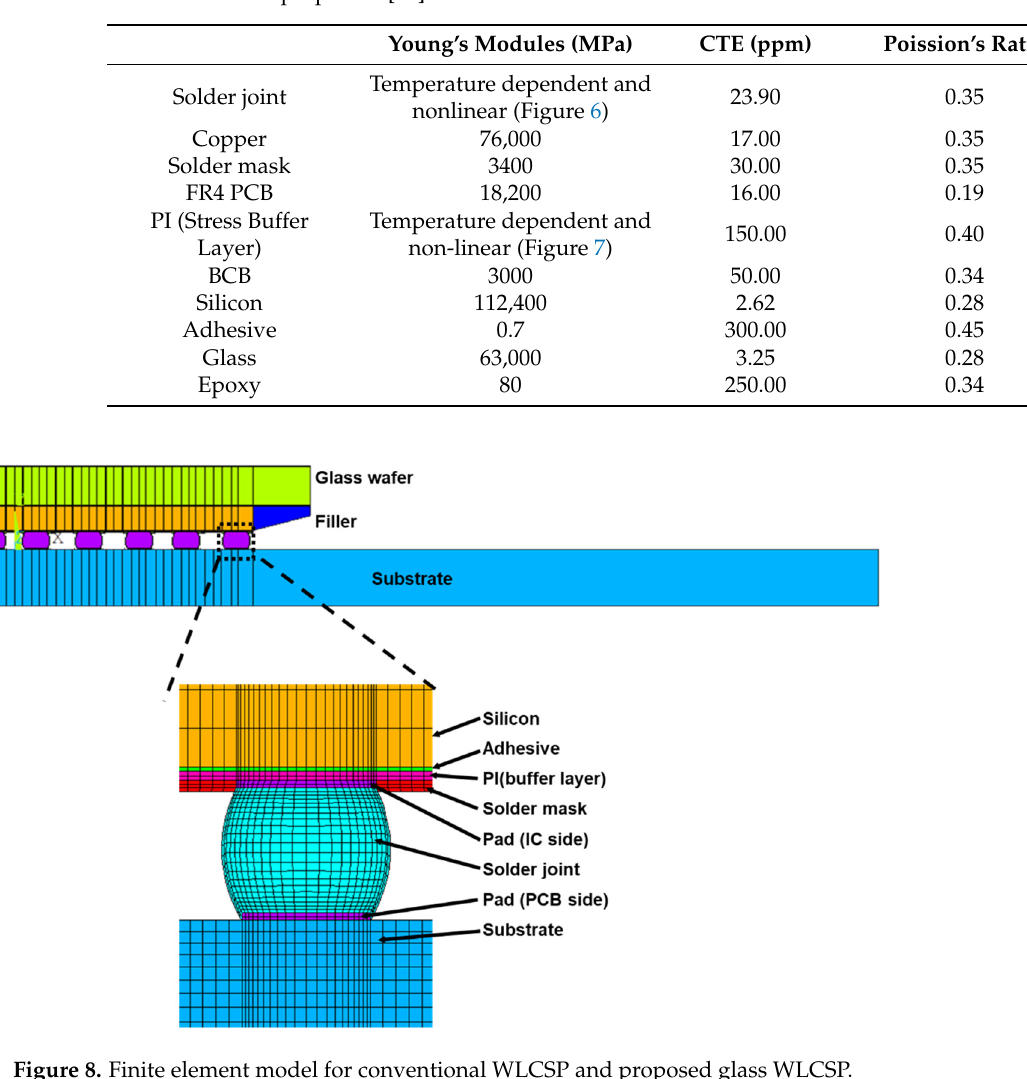
Figure 7. Nonlinear mechanical response of PI with different temperatures [15] (Copyright 2020 EuroSimE). Table 1. Material properties [14].